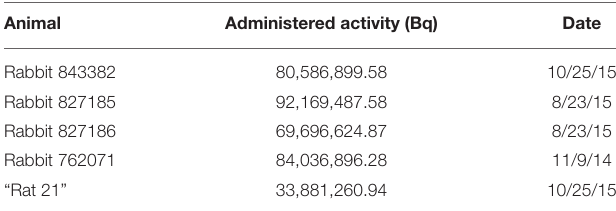
TABLE 1 | Administered activity (primarily 90 Y, for additional explanation see Table 2 ) on the day of animal treatment. Animal